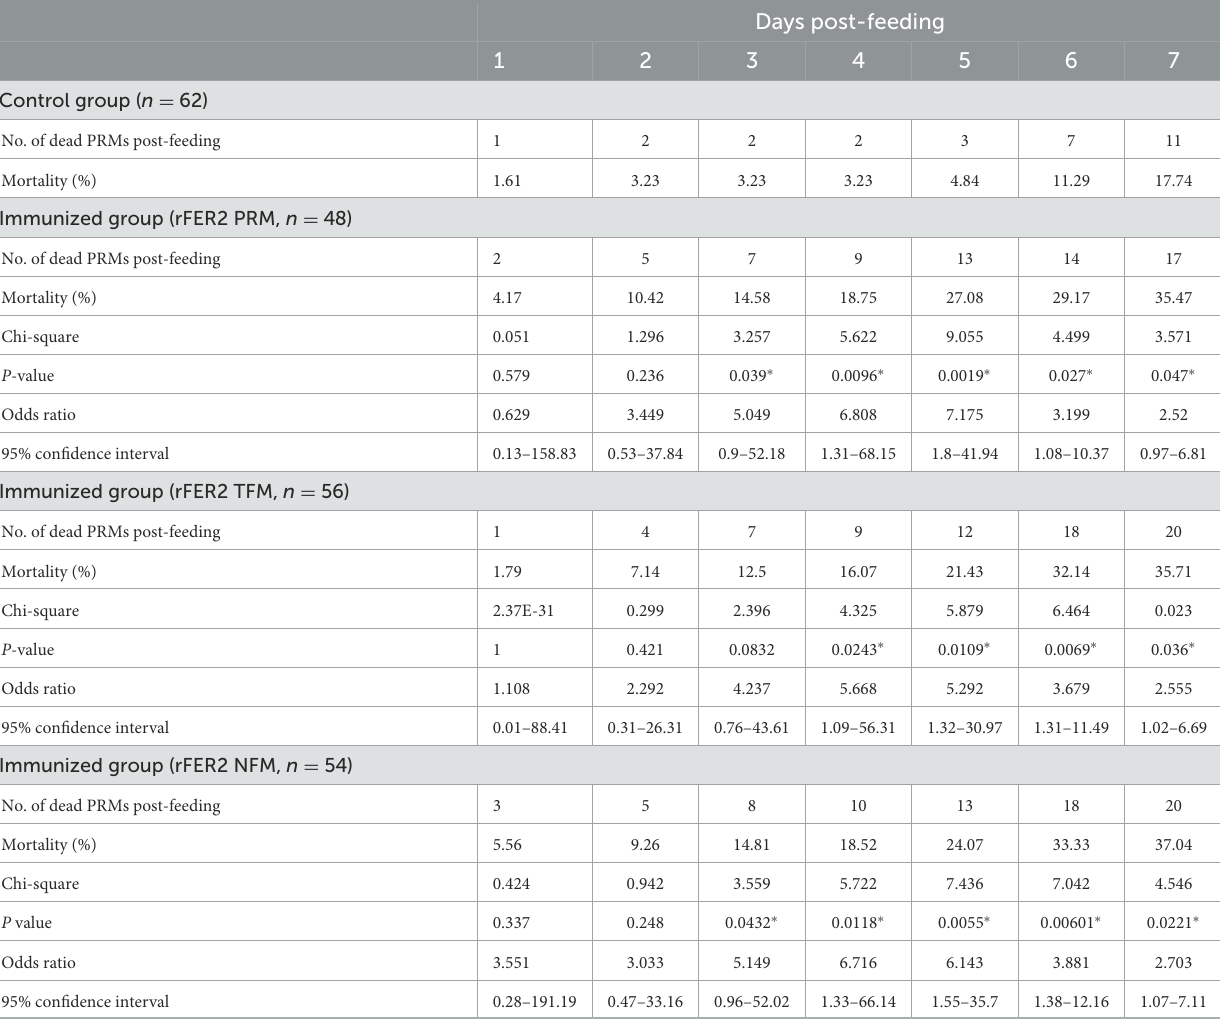
TABLE 4 Mortality of PRMs fed plasma from chickens immunized with recombinant ferritin 2 from different species of mites (experiment 2).